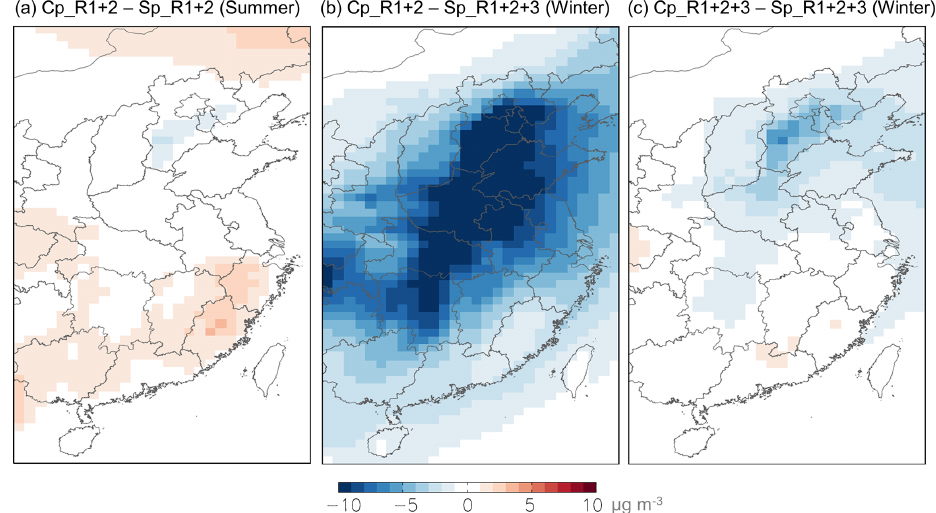
Figure 5. The differences in seasonal mean mass concentrations of SOA between (a) the Cp_R1 + 2 and Sp_R1 + 2 simulations in summer,